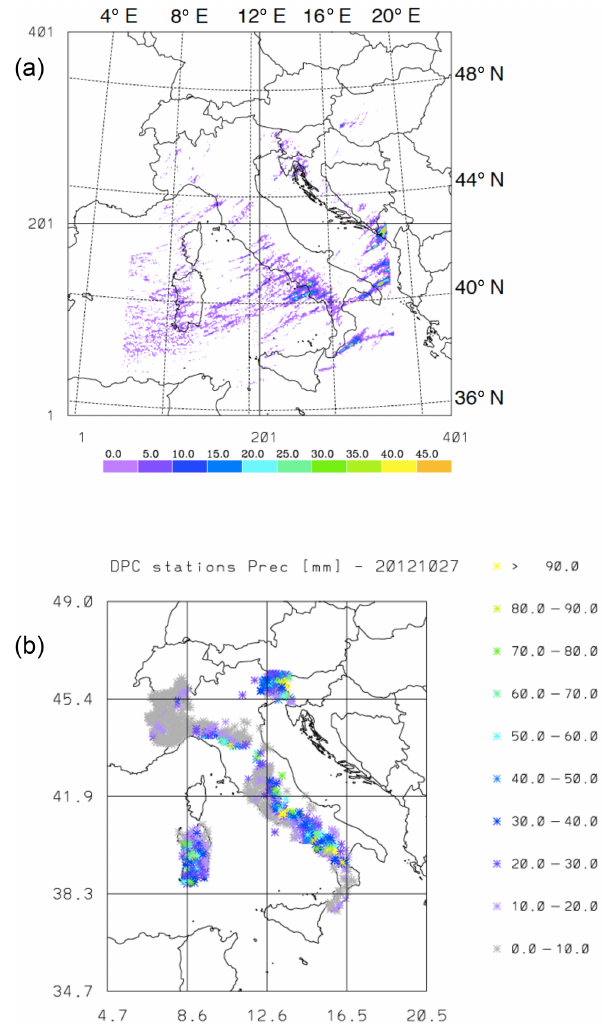
Figure 4. (a) Lightning density on 27 October 2012 (number of flashes/16km 2 ). The lightning number is obtained by remapping the lightning observed by LINET onto the RAMS grid at 4km hor- izontal resolution. Note that the lightning is cut on all sides (this is especially evident on the eastern bound) because of the data avail- ability. The bottom and left axes show the grid point number, while the top and right axes show the geographical coordinates. (b) Daily precipitation (mm) recorded by available rain gauges on 27 Octo- ber